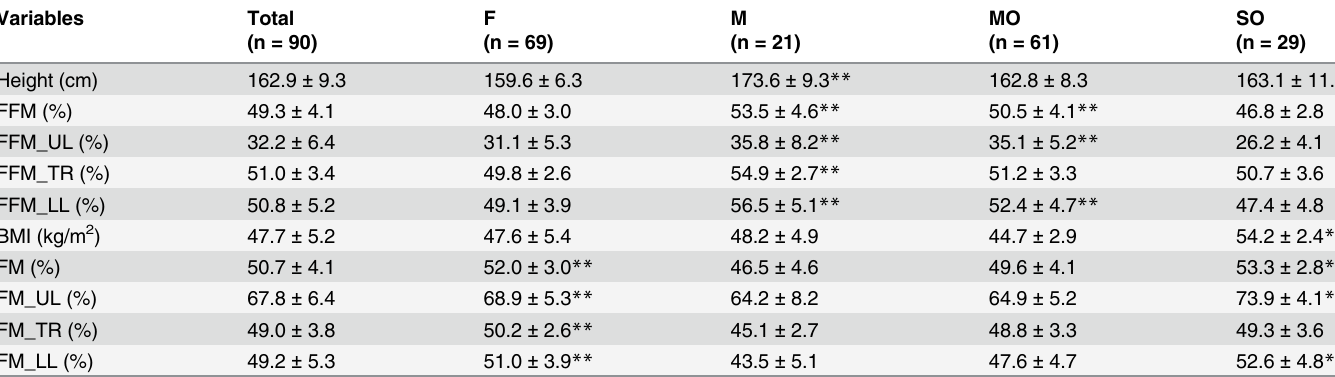
Sample size was estimated using a linear regression analysis between 6MWD (response vari- able) with gender and obesity grade. The minimum sample size was calculated to be at least 90 subjects. A p < 0.05 value was considered as significant. All data were presented as mean, standard deviation and 95% confidence intervals. Table 2. Anthropometric characteristics and body composition of the study participants determined by BIA.